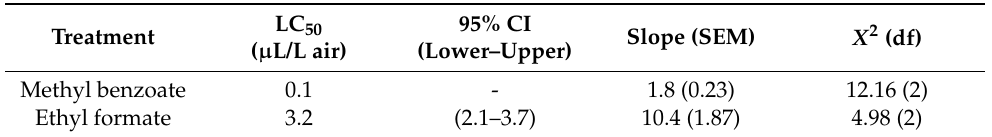
Table 2. Probit analysis of concentration–mortality responses of Plodia interpunctella adults exposed to various concentrations of methyl benzoate (MBe) and ethyl